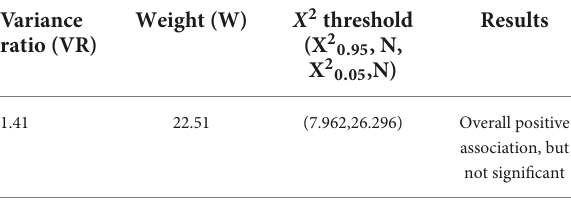
TABLE 3 Indices of inter-specific association between Hopea hainanensis and tree